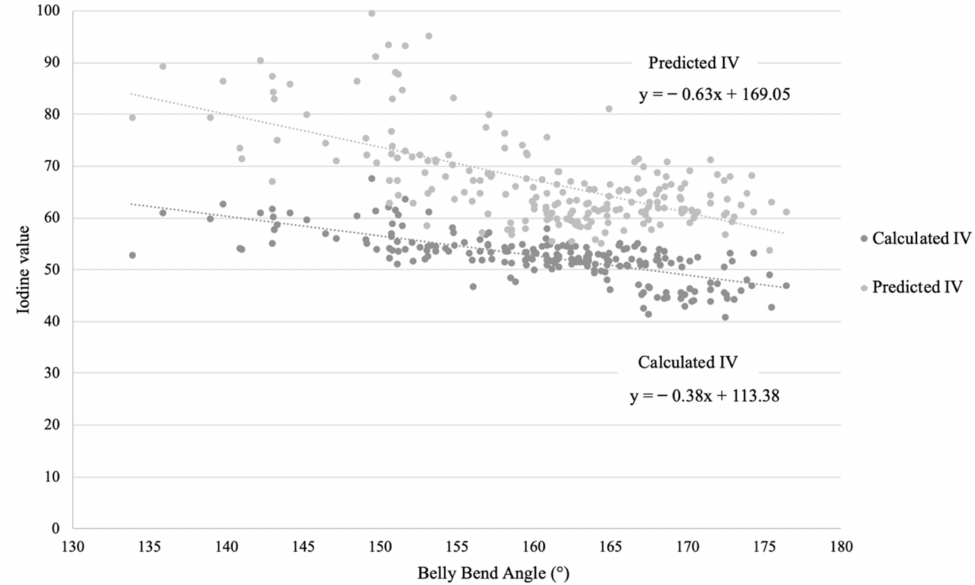
Figure 1. Relationships of predicted (NitFom TM ) and calculated IV with belly bend